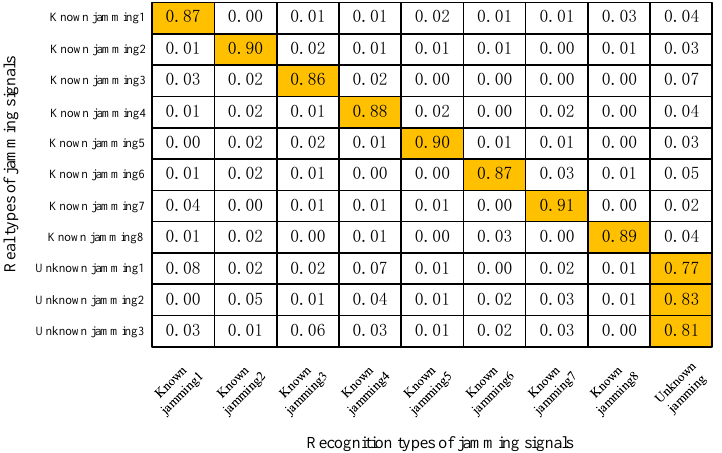
Figure 16. Recognition results of model based on confidence score.